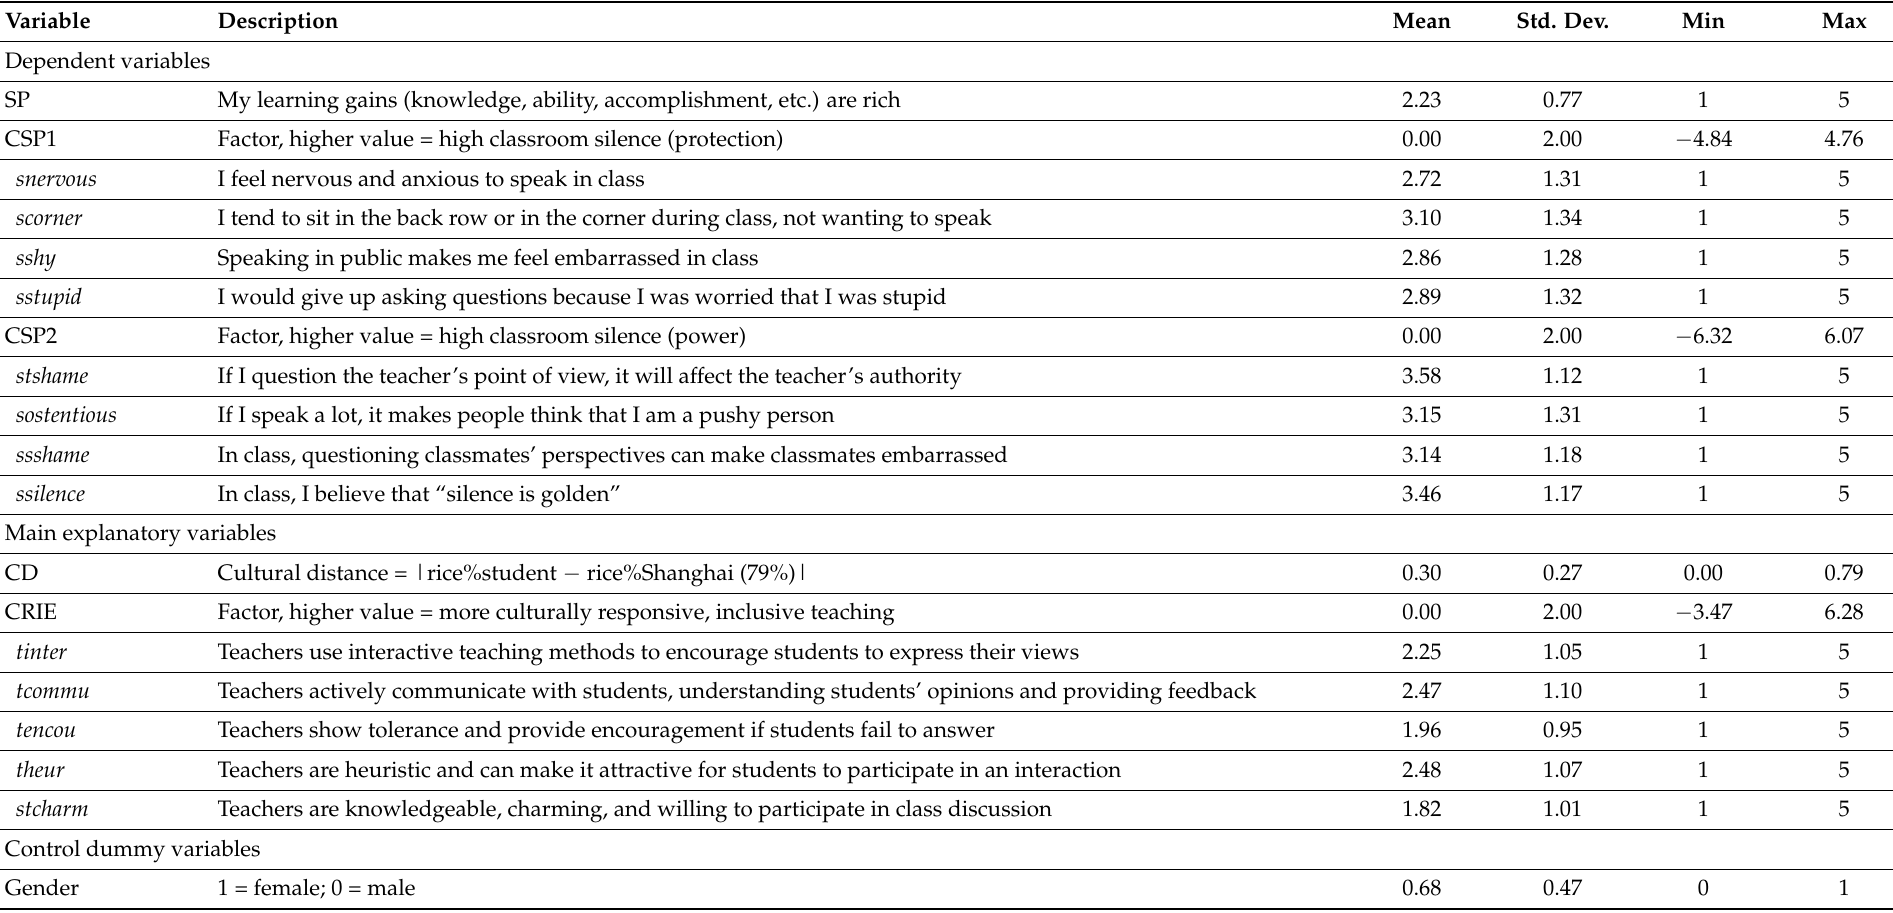
Table 1. Descriptive statistics of variables, 1051 college students in